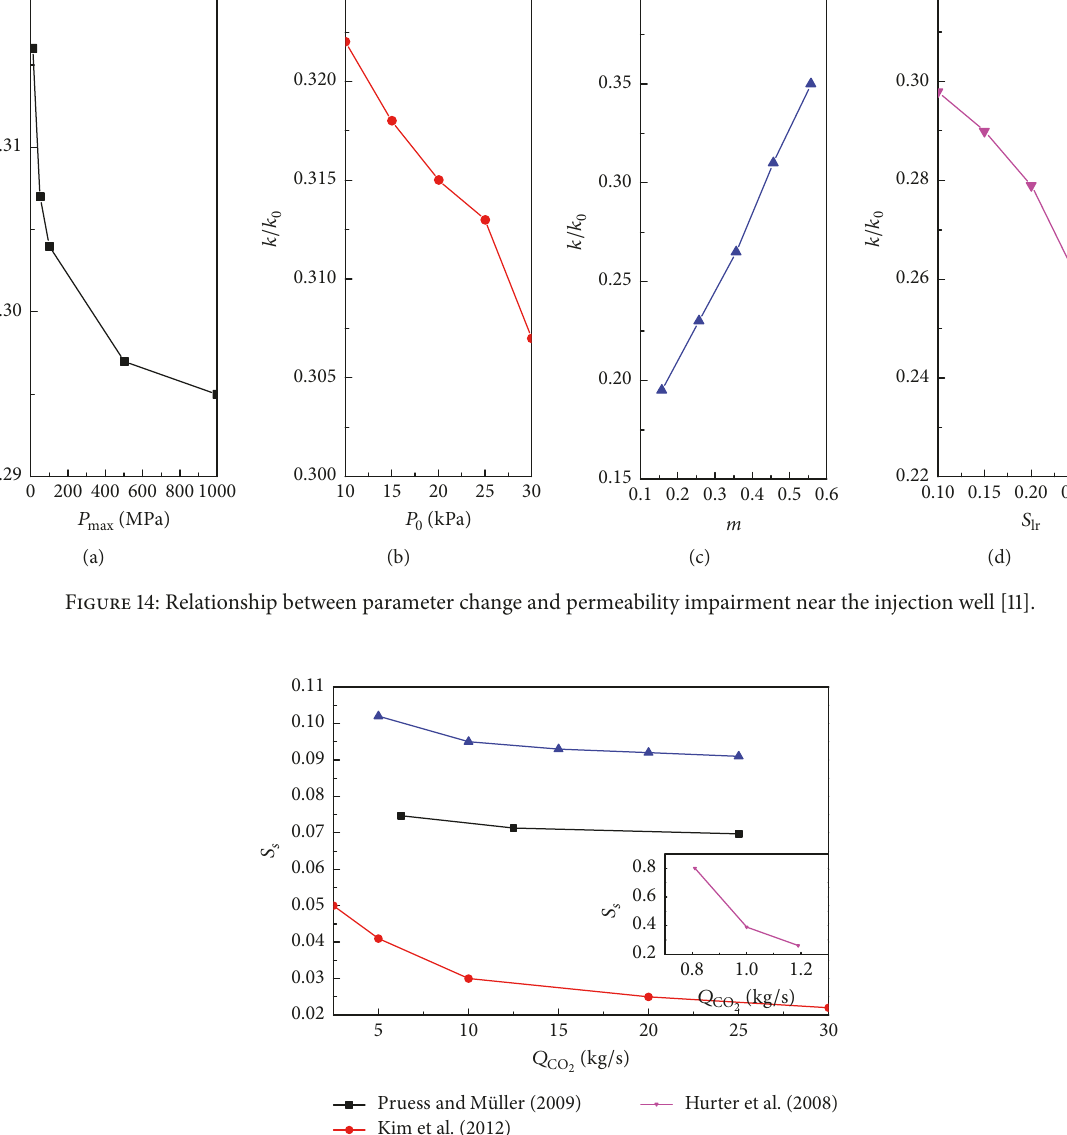
(a small plot is a case where 𝑄 CO 2